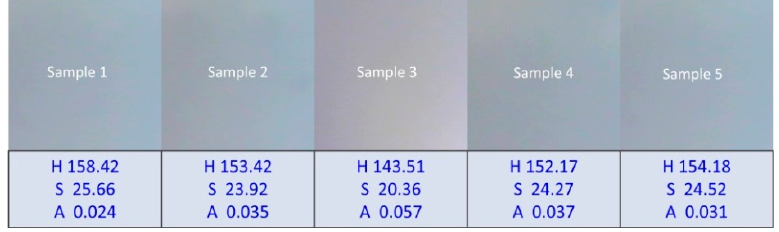
Figure 11. Partial actual water sample data.